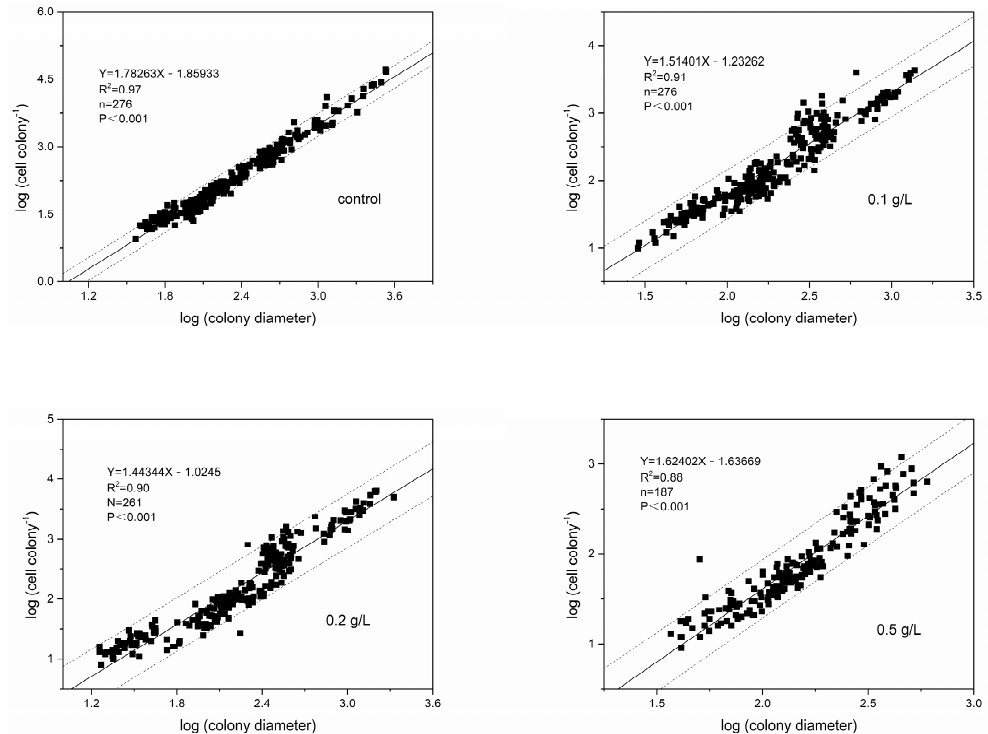
Figure 7. Relationship between the log cell number per colony and log colony diameter. ( a ) control group, ( b ) 0.1 g/L MC-treated group, ( c ) 0.2 g/L MC-treated group and ( d ) 0.5 g/L MC-treated group. Solid lines are linear regressions and dotted lines represent 95% confidence intervals, and n represents the number of